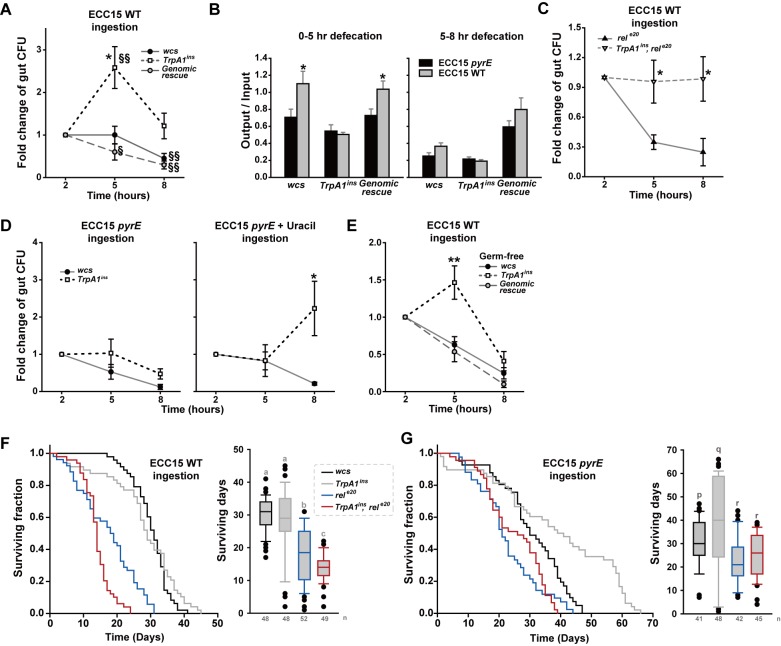
Defecation deficit in TrpA1 mutants is associated with longer ECC15 gut persistence and rel-dependent increased mortality.A Gut persistence presented as relative colony-forming units (CFUs) at 2-, 5- and 8-hr time points of the experiments (n = 6–12). The time point indicates the time after start of ECC15 feeding. After ingestion of ECC15-GFP for indicated time, the dissected intestine was homogenized and CFUs of intestinal ECC15-GFP were determined to estimate bacterial growth in the gut. CFUs at 5 and 8 hr time points were divided by that at 2 hr time point to minimize experimental variation. B Defecation in the assay time windows of 0–5 hrs and 5–8 hrs is displayed as output/input (n = 5–17). Consistent with (A), TrpA1-dependent defecation is more prominent between 0 and 5 hr time points. C Loss of TrpA1 increases ECC15 gut persistence in the gut deficient for the imd pathway. D Ingestion of ECC15 pyrE does not differentiate wcs and TrpA1ins in gut persistence (Left). Supplementation with uracil allows ECC15 pyrE to proliferate in the guts of TrpA1ins more than wcs albeit at a delayed time point of 8 hrs (Right). E Germ-free flies show similar difference in ECC15 gut persistence among the wcs, TrpA1ins and genomic rescue strains, indicating that the persistence phenotypes resulted from genetic manipulation in flies not commensal bacteria which may differ in the fly strains. F and G Ingestion of ECC15 shortens life span of immune-compromised flies. When daily ingesting ECC15 WT (F), the rele20 mutant defective in the imd innate immune pathway shows reduced life span, which was further exacerbated by additional loss of TrpA1, indicating uracil-dependent defecation contributes to ECC15 resistance. Ingestion of ECC15 pyrE did not differentiate rele20 and TrpA1ins, rele20. Left, Kaplan-Meier LogRank survival analysis of indicated genotypes ingesting ECC15 WT (F) or pyrE (G) (p<0.001). Right, Life span distribution of the animals tested in the panel of Left. All pairwise multiple comparison by Holm-Sidak method. Letters indicate significantly distinct groups (p<0.001). §: p<0.02, §§: p<0.01, ANOVA Repeated Measures Holm-Sidak method (A). Mean ± SEM. *: p<0.05, **: p<0.01, Student’s t- or Tukey tests.